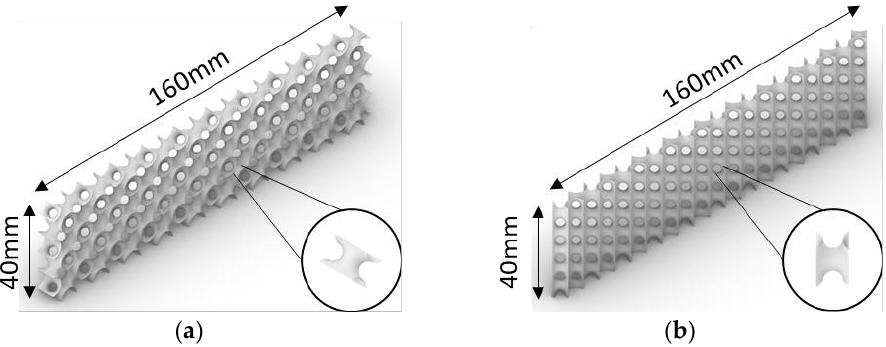
Figure 7. Different cell directions of the S2 lattice core: ( a ) original and ( b ) vertical direction (i.e., S2 90 ). Table 7. Percentage difference between S2 and S2 90 .